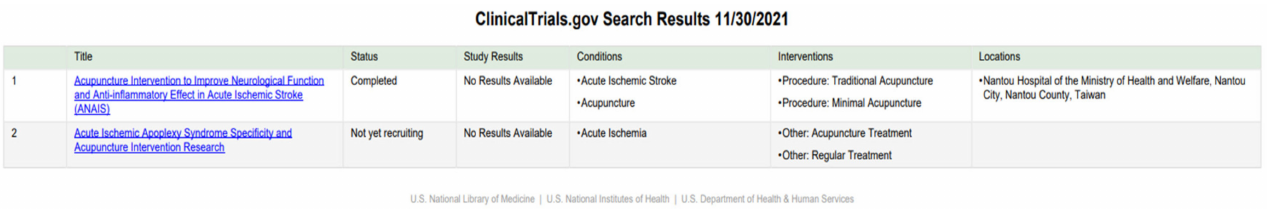
Figure 4. Clinical trials for Electro-/Acupuncture interventions in acute ischemic stroke.